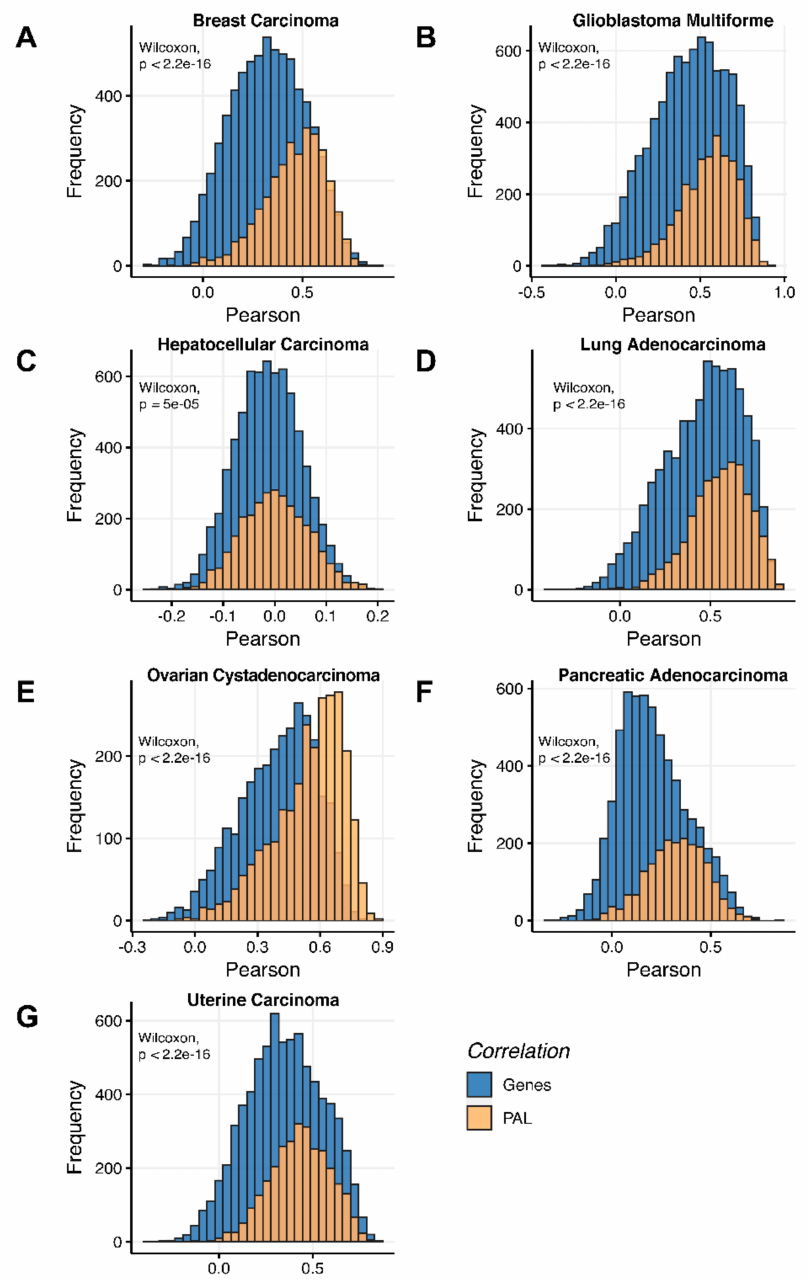
Figure 13. Gene-to-gene and PAL-to-PAL Pearson correlation between RNA and protein expres- sion levels estimated given gene or molecular pathway across ( A ) Breast Invasive Carcinoma, ( B ) Glioblastoma Multiforme, ( C ) Hepatocellular Carcinoma, ( D ) Lung Adenocarcinoma, ( E ) Ovar- ian Serous Cystadenocarcinoma, ( F ) Pancreatic Ductal Adenocarcinoma and ( G ) Uterine Corpus Endometrial